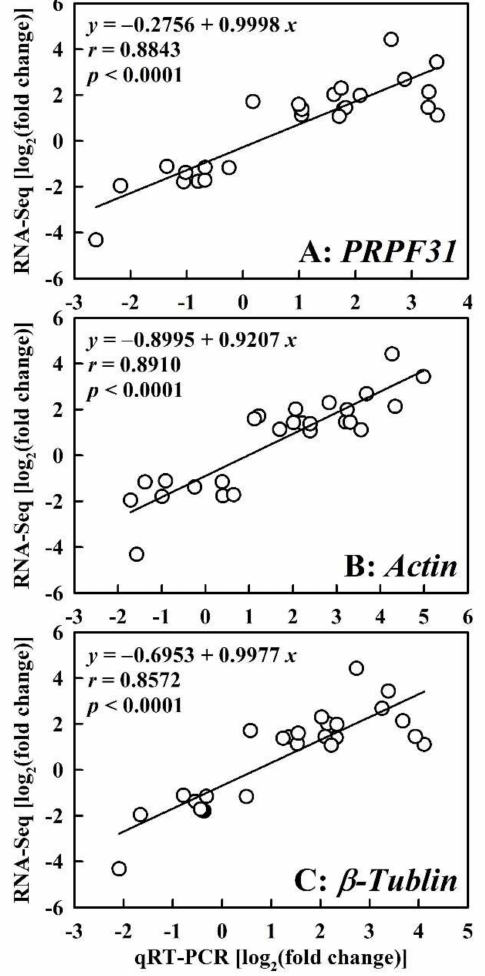
Figure 3. RNA-Seq data in relation to qRT-PCR results using U4 / U6 small nuclear ribonucleoprotein PRP31 ( PRPF31 ( A ), actin ( B ), and β - tubulin ( C ) as internal standards. Bars represent means of three biological and two technique replicates. RNA-Seq data from Table